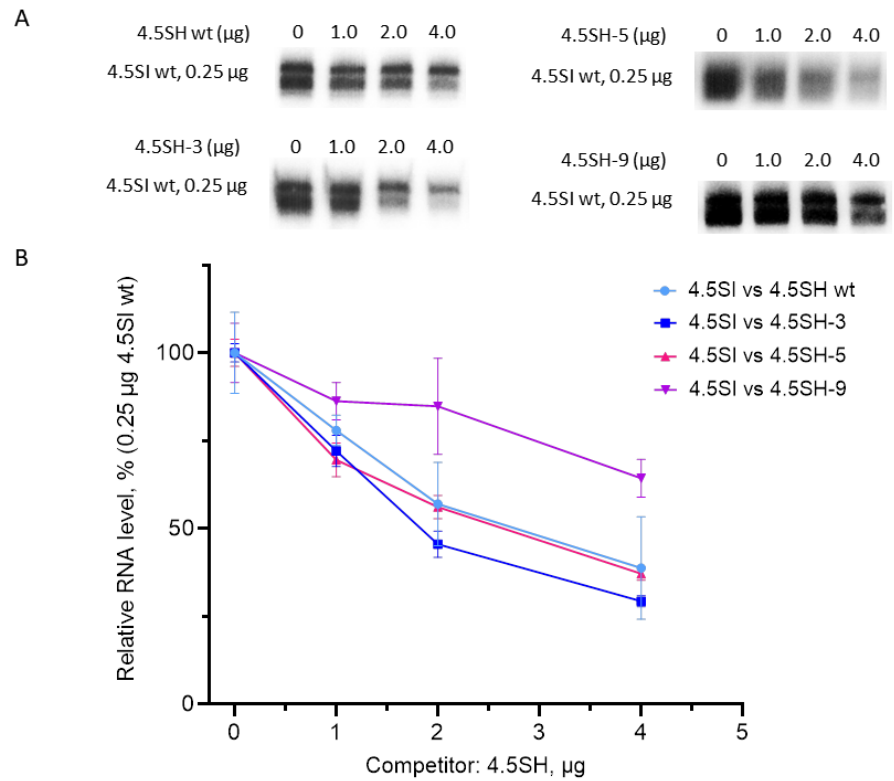
Figure 8. Transcriptional competition of 4.5SI gene with 4.5SH gene derivatives in transfected HeLa cells. ( A ) Northern blot detection of 4.5SI RNA. The target plasmid containing the 4.5SI gene (0.25 µ g) was added to each transfection sample, and the amount of the competitor plasmid containing the 4.5SH gene (SHwt) or its derivatives (SH-3, SH-5, and SH-9) in the transfection mixture are indicated above the lanes. ( B ) Quantitative analysis of the Northern blot data. The level of 4.5SI RNA without competition is taken as 100%, and the amount of the competitors is indicated on the X-axis. Error bars, SD, n = 3 (see original Northern blot images for three replicates in Figure S4).